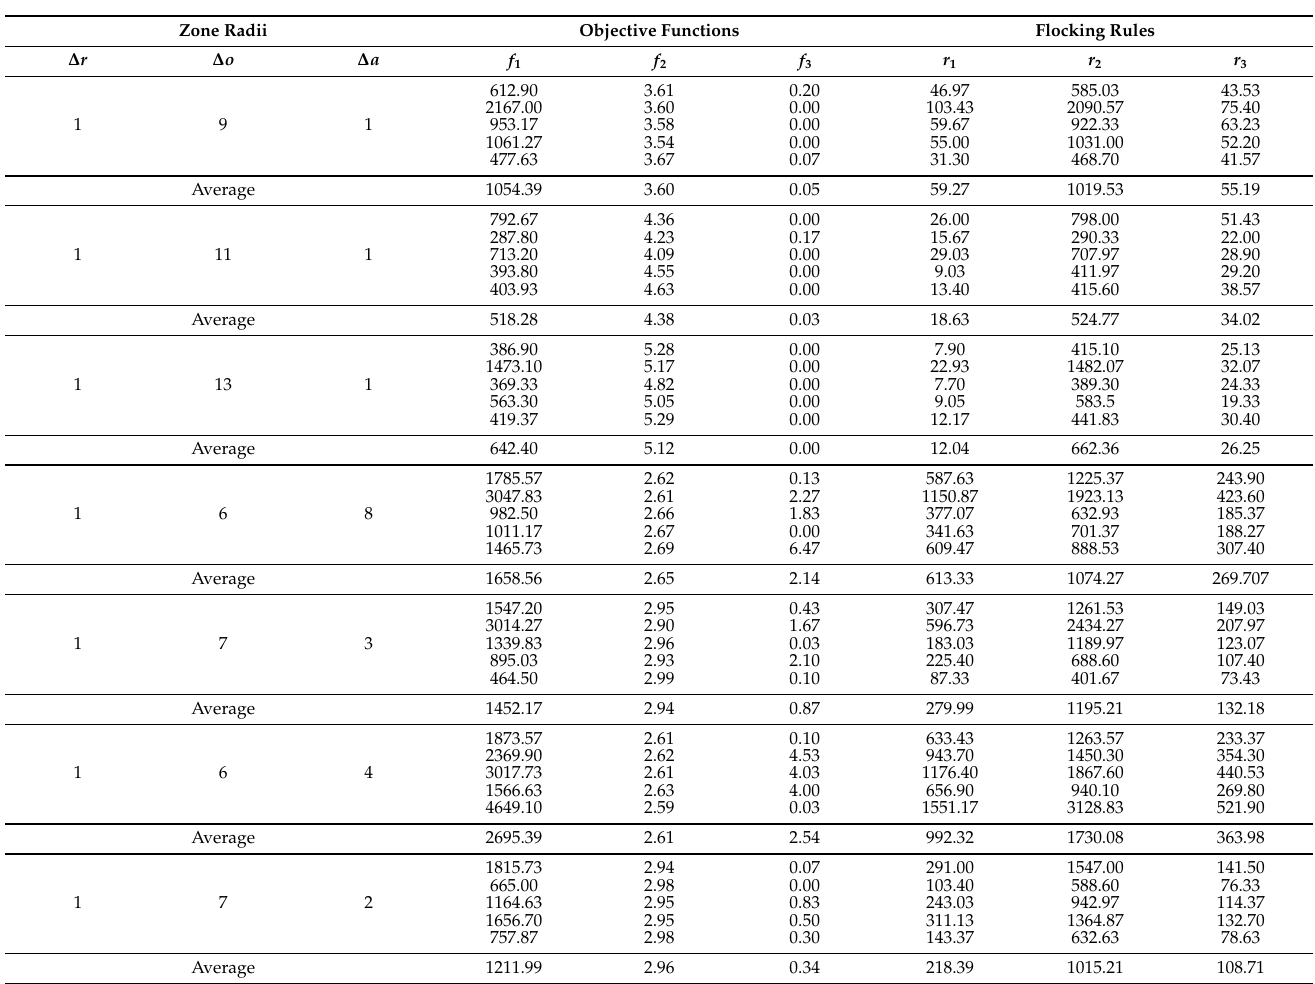
Table A2. Results of testing perception zones for flocks with 30